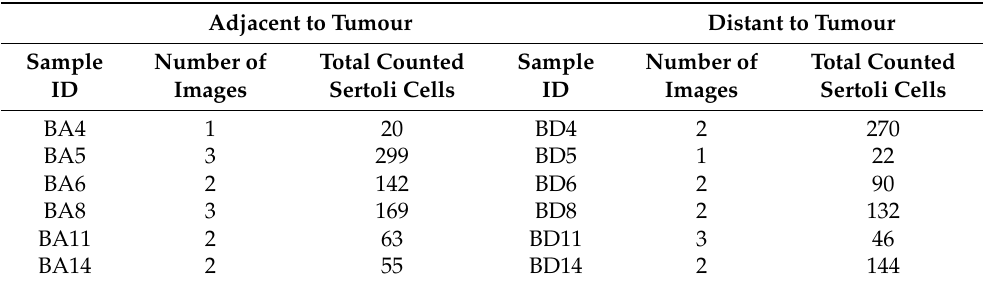
Table 4. Details of the tissue used for the quantification of cytokeratin expression in Sertoli cells of GCNIS containing tubules from biopsies collected adjacent to, and distant from the